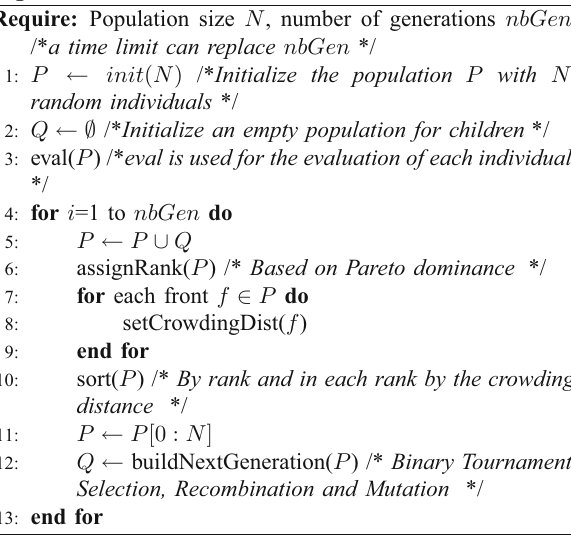
Algorithm 2 Pseudocode for NSGA-II